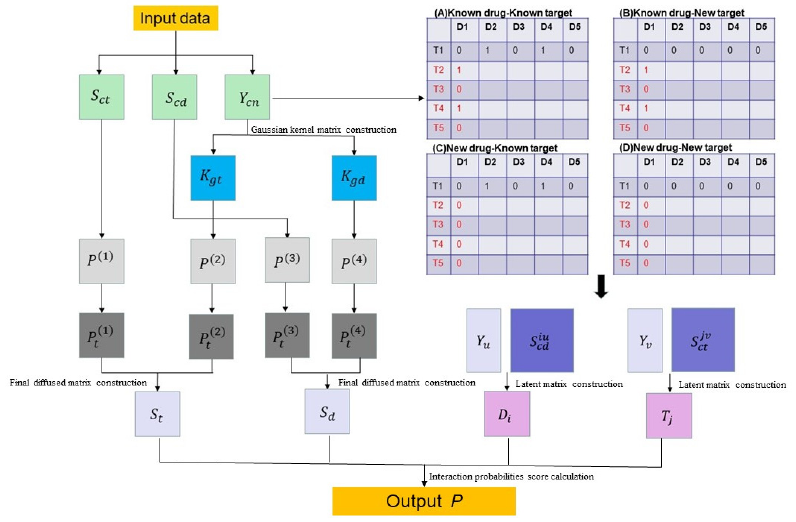
Figure 1. Basic architecture of DNIMLF.